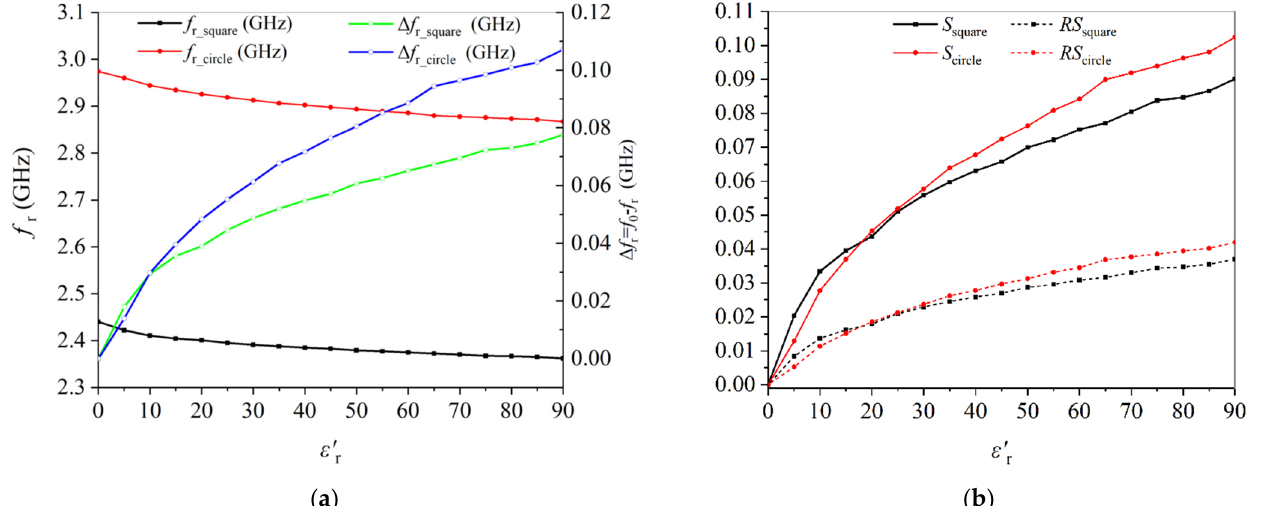
Figure 5. Comparison of sensitivity of the two resonators. ( a ) frequency and frequency shift, ( b ) sensitivity versus change in dielectric constant.